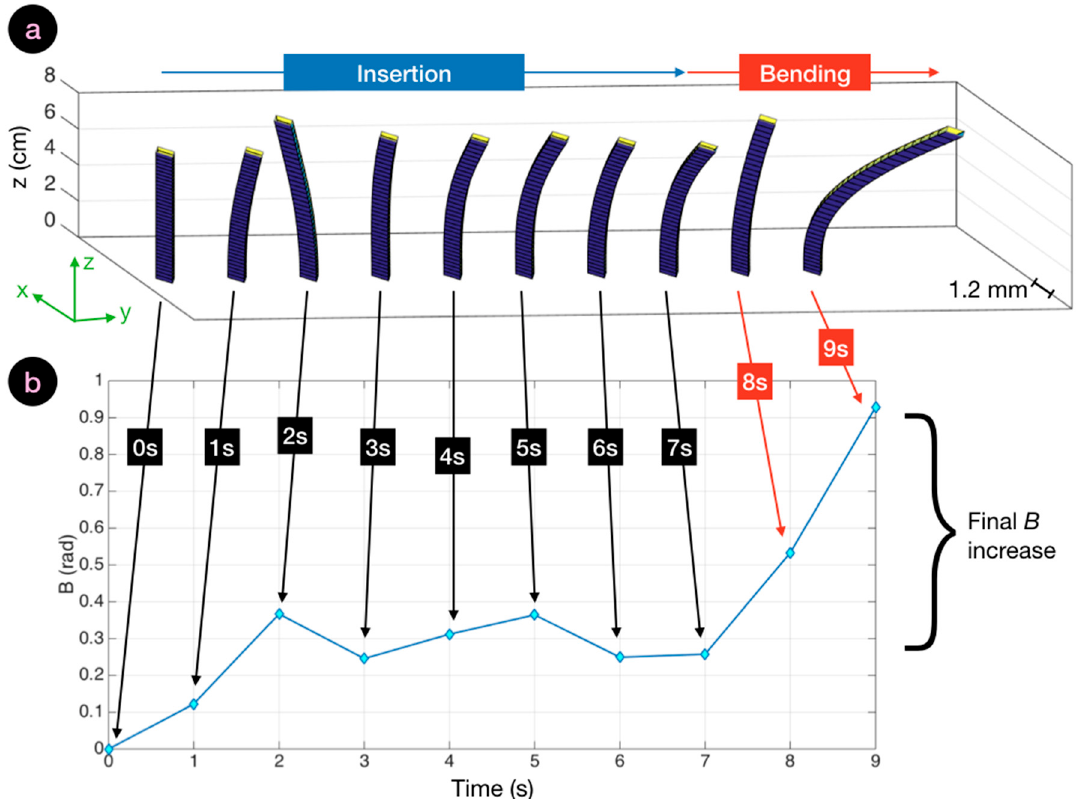
Figure 9. Bending cinematic for a failed insertion and corresponding SBPA chart. ( a ) Cinematic of the straight insertion (9 s duration), displaying the reconstructed silhouette of the needle (1.2 mm cross-section on xy , 8 cm length along z ) through the whole insertion. ( b ) Corresponding SBPA chart showing the value of B corresponding to each bending pattern.